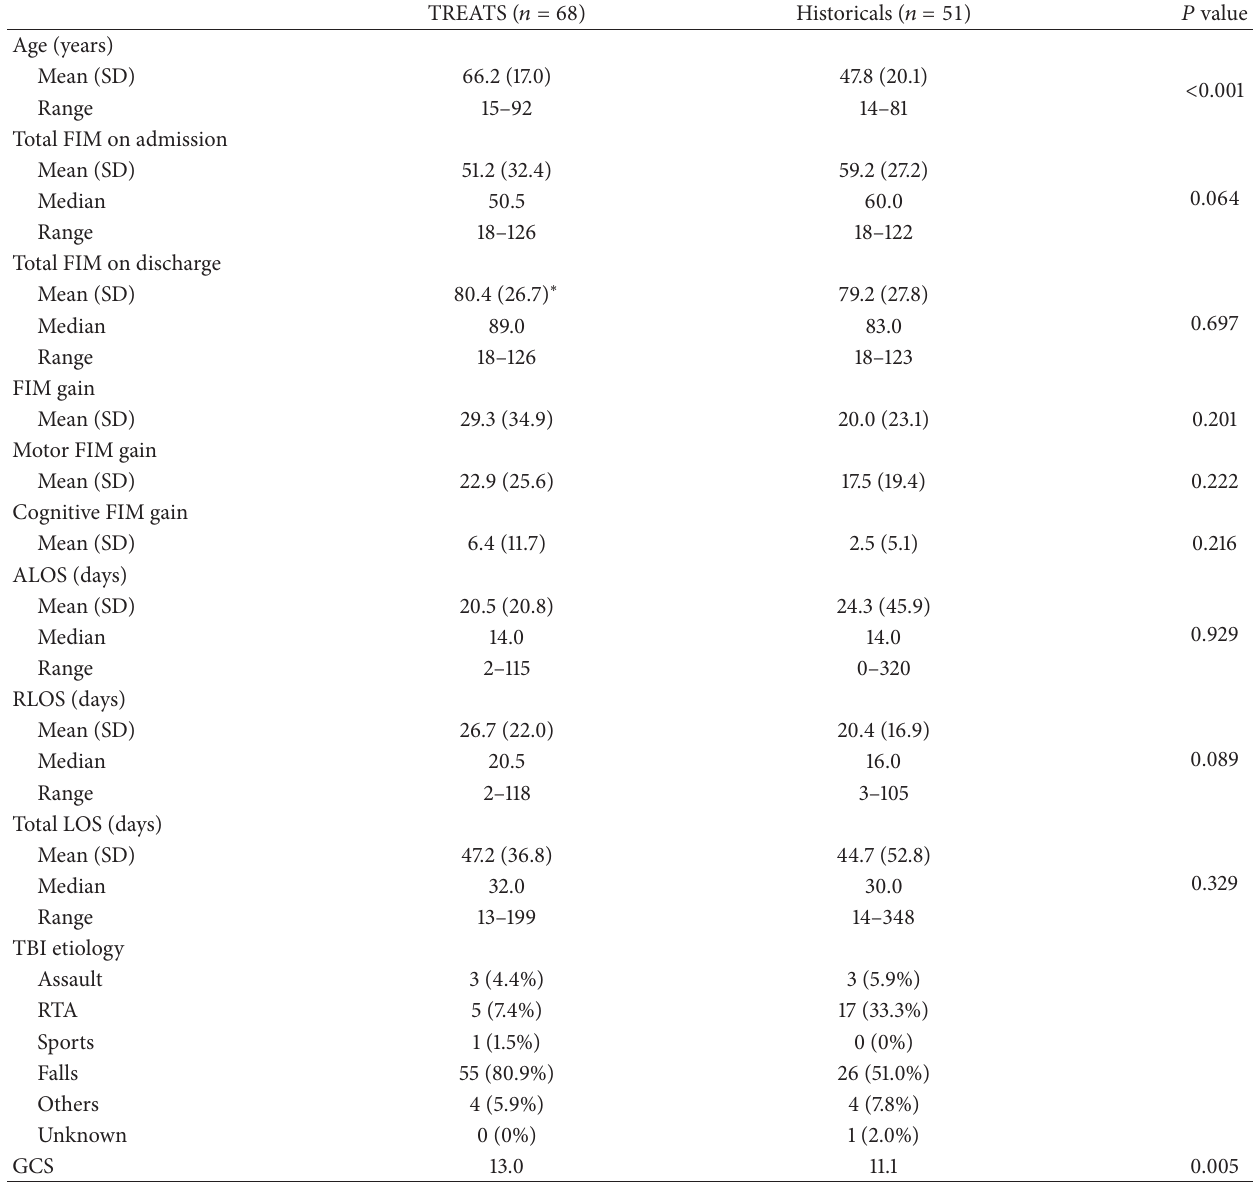
Table 5: Demographics and functional outcomes of TREATS versus